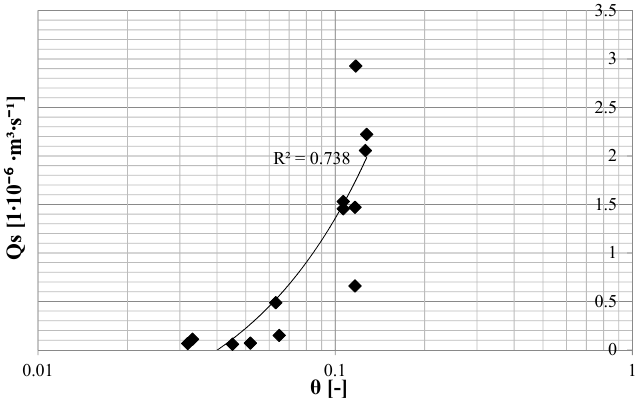
Figure 10. Shields parameter and the sediment discharge correlation graph, where θ —dimensionless shear stress in bed region; Q s —sediment discharge; R 2 —coefficient of determination.